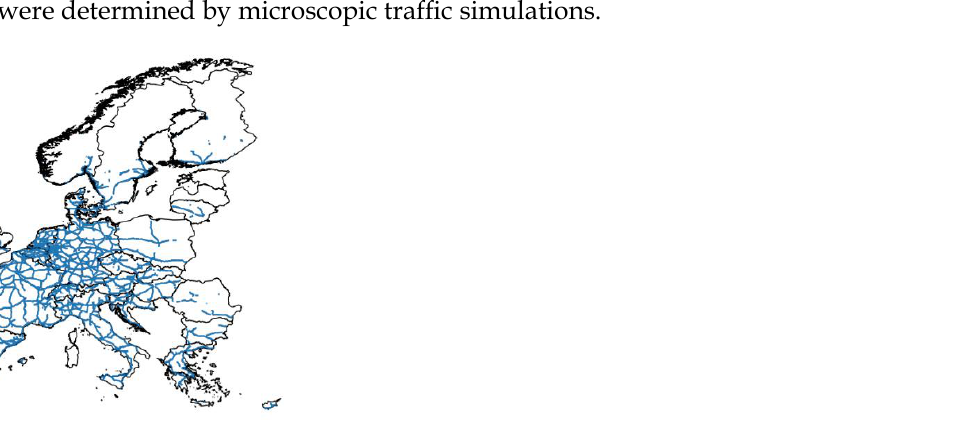
Motorway network of EU27, Norway, Switzerland and the United Kingdom. Source: